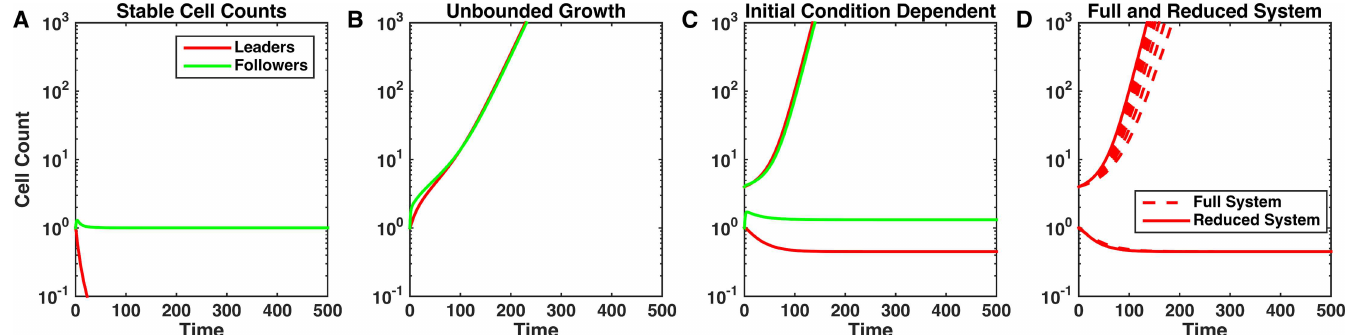
Fig 2. Ecosystem dynamics depend strongly on the feedbacks strength. Characteristic examples of the cancer cell population dynamics in the model for different strength of the competition between leader and follower cell populations, c , and leader population intrinsic feedback, s (A: s L = 1.2, c = 0.6), grow unboundedly (B: s L = 1.2, c = 0.05), or be dependent on the initial tumor size (C: s L = 2, c = 0.375). D: Comparison of full, 7 ODE, system (dashed lines) and reduced, 2 ODE (see Methods). Simulations of the full system are given where γ V = γ P = γ N = γ OL = γ OF (cid:17) γ . We define ε = r F / γ and show simulations of the full system with ε between 0.001 and 1 for leader cell dynamics with parameter values as in C. There was less than a 5% difference in growth and decay rates for ε <